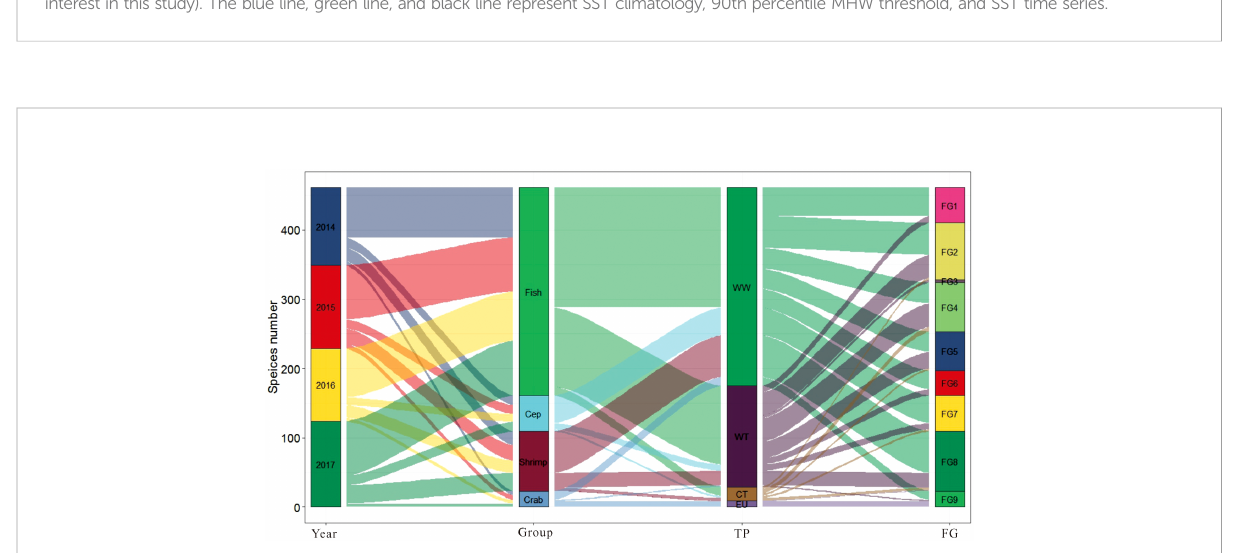
FIGURE 4 Event line for detected marine heatwaves at the study area during (A) 2014 – 2015 and (B) 2016 – 2017 (red fi lled area is the marine heatwaves evens of interest in this study). The blue line, green line, and black line represent SST climatology, 90th percentile MHW threshold, and SST time series.